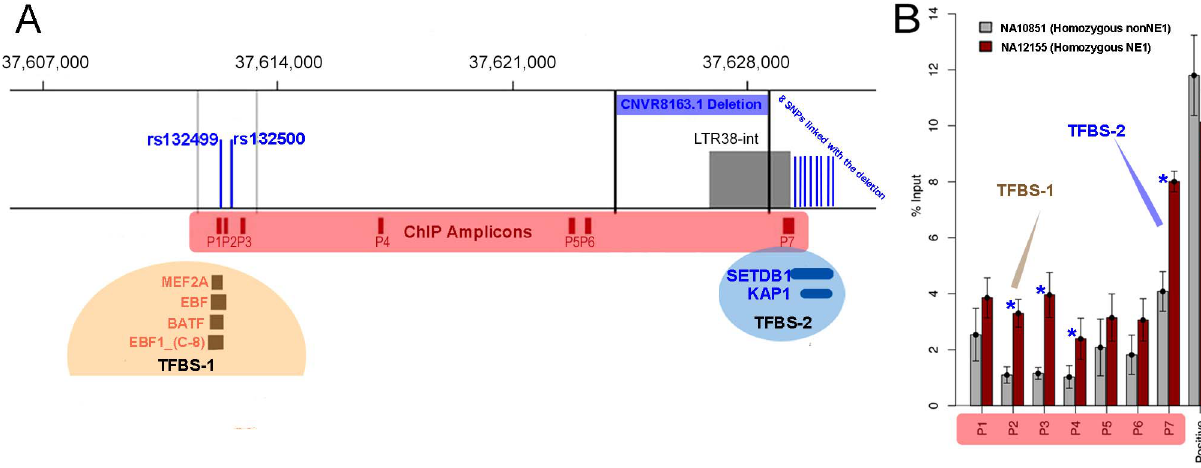
Figure 5. The regulatory functions of NE1 locus. (A) The LTR region was determined using the Repeat Masker Track version 3.2.7 [63]. Dark red boxes indicate the location of amplicons for ChIP qPCR. TFBS-1 and TFBS-2 refers to the two predicted transcription factor binding sites that were predicted by the latest ENCODE project data release, available in UCSC Genome Browser for the hg19 assembly. The CNVR8163.1 deletion polymorphism is flanked by black vertical lines. The blue vertical lines indicate the approximate locations of SNPs that differentiate between NE1 and nonNE1 haplogroups and overlap the TFBS-1 and TFBS-2 transcription factor binding sites. The 8 SNPs that overlap with TFBS-2 are from 5 9 to 3 9 , rs132525, rs4306795, rs4434085, rs5750701, rs35853418, rs6001308, rs6001309, and rs9622868) (B) Chromatin immunoprecipitation quantitative PCR (ChIP-qPCR) results across the NE1 locus for representative samples NA12155 and NA10851 that belong to NE1 and nonNE1 haplogroups, respectively. The locations of the amplified segments (P1–P6) are shown in dark red rectangles in (A). The positive control primers amplify a segment within BCL6 gene on chromosome 3 that is known to have high H3K4me2 occupancy. The blue stars indicate significant differences in qPCR amplification between NE1 and nonNE1 haplotypes (p , 0.01). The brown and blue arrows indicate qPCR primers that are closest to the predicted transcription binding sites (P1, P2, P3 for TFBS-1 and P7 for TFBS-2). Overall, our results demonstrate that H3K4me2 is enriched in NA12155 cells, which harbor the NE1 deletion as compared to NA10851 cells which do not have the deletion (data plotted represents the average of four replicate experiments 6 Std. Error).